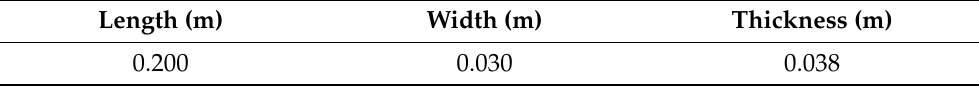
Table 10. Dimensions of the test specimen for verification of shear strength.